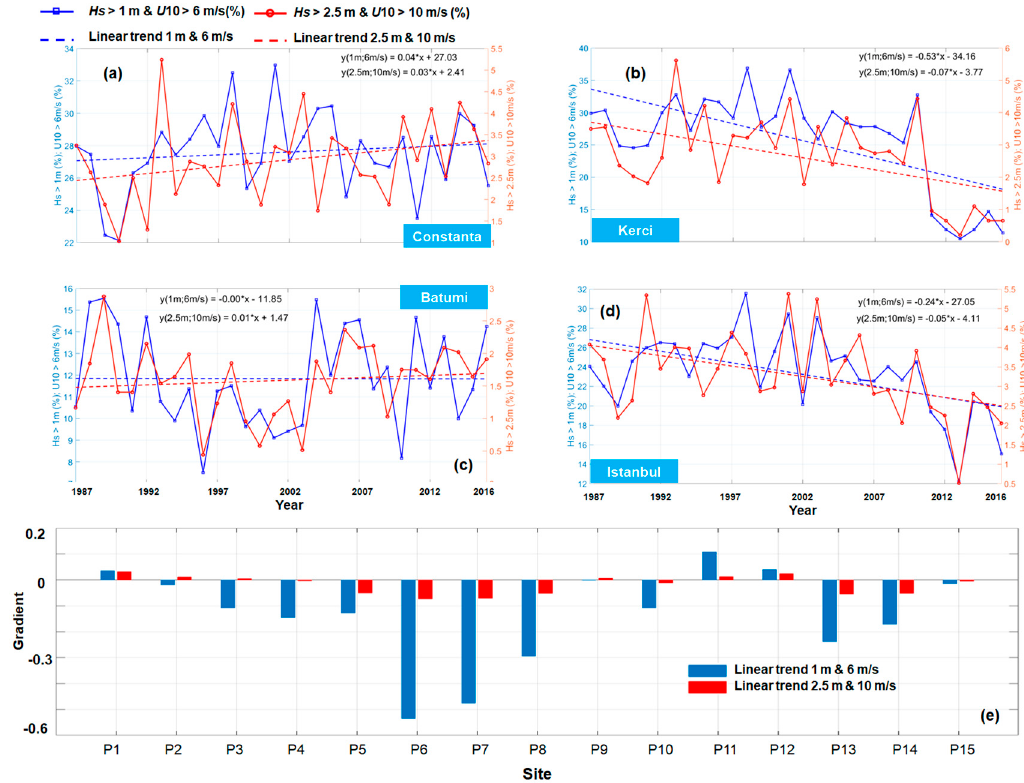
Figure 12. Inter-annual distribution of the wind and wave conditions, where: ( a – d ) annual values and linear trends reported for the Constanta, Kerci, Batumi and Istanbul sites; ( e ) gradient distribution for all the reference sites.